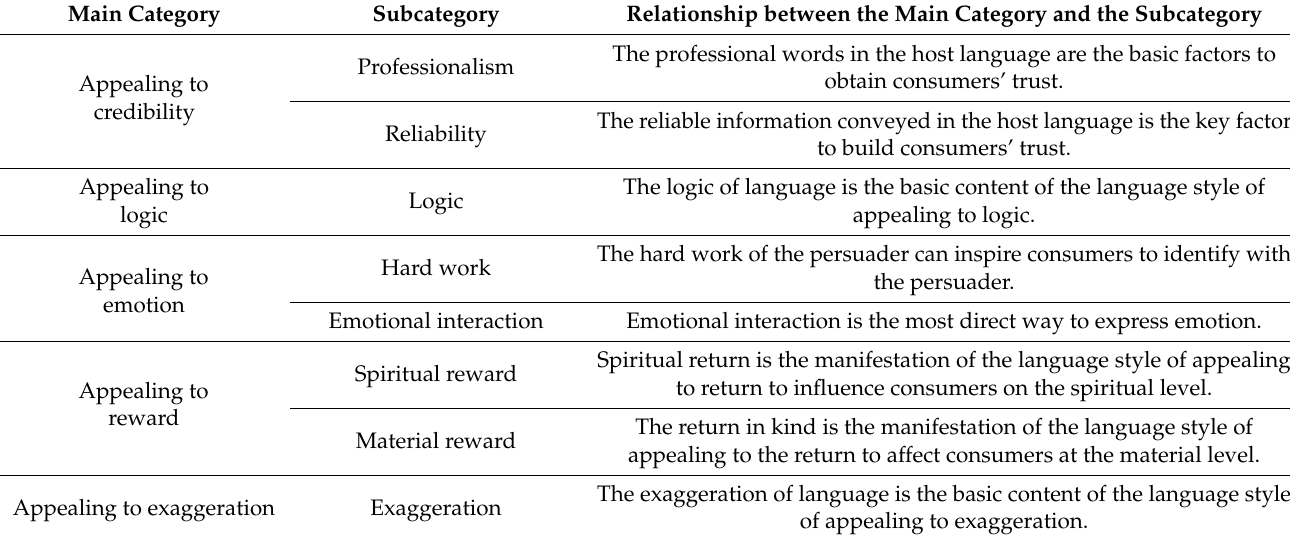
Table 4. Correspondence between main category and